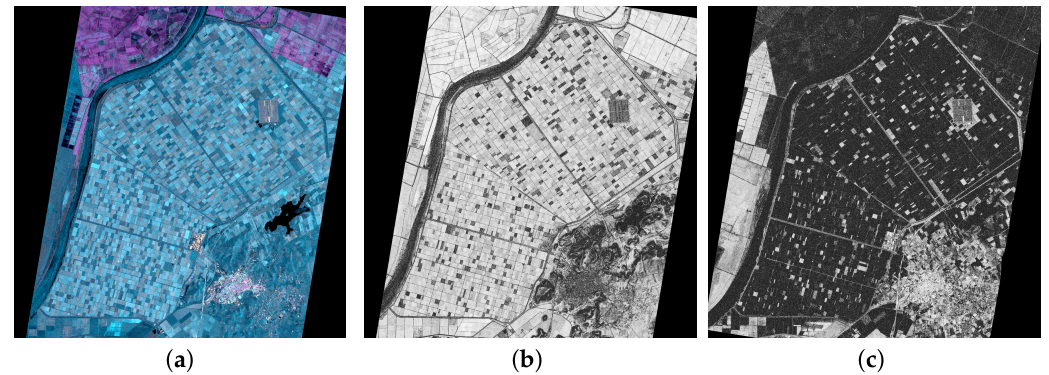
Figure 3. Images of some observables that are used for classification: ( a ) RGB polarimetric composite (Red = P1, Green = VV, Blue = P2) on 7 July 2015, ( b ) Single-pass coherence at HH channel on 7 July 2015, ( c ) Repeat-pass coherence at HH channel between 7 July 2015 and 18 July